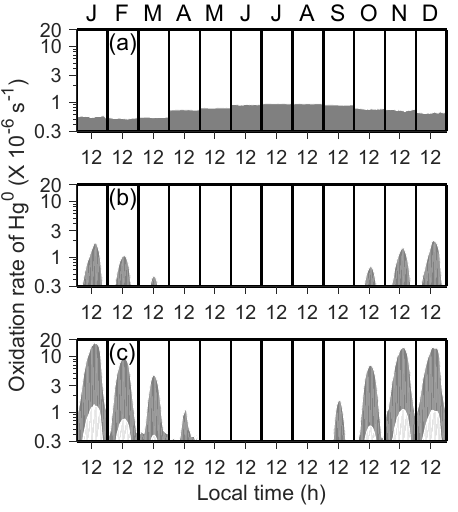
Figure 2. Uncertainty ranges of atmospheric Hg 0 oxidation rates within the inversion/mixed layers: (a) O 3 , (b) OH, and (c) Br. Monthly and diurnal variations in the year 2013 are shown in the shaded regions. Note that the y axis is in log